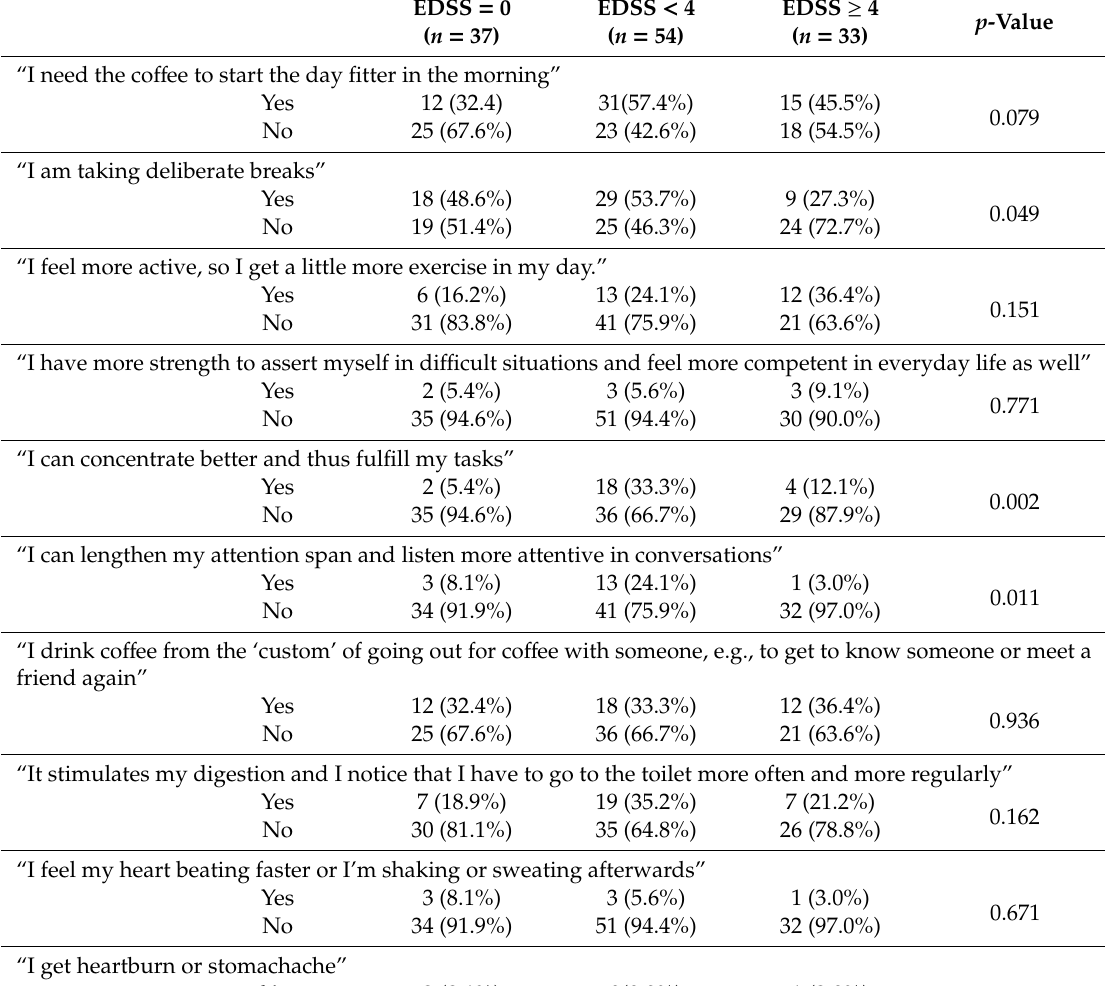
Table 6. E ff ects of co ff ee consumption categorized based on the EDSS value. EDSS =